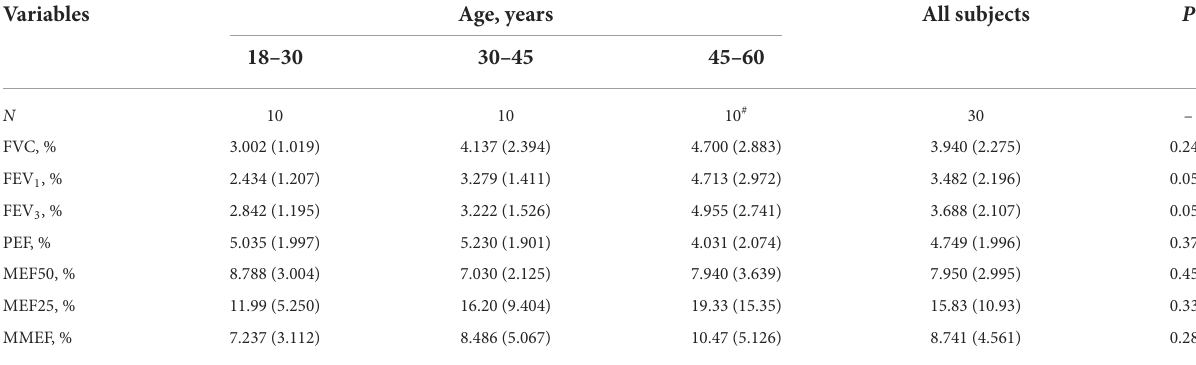
TABLE 4 Comparison of the diurnal variation of large- and small-airway function variables according to age. Variables Age, years All